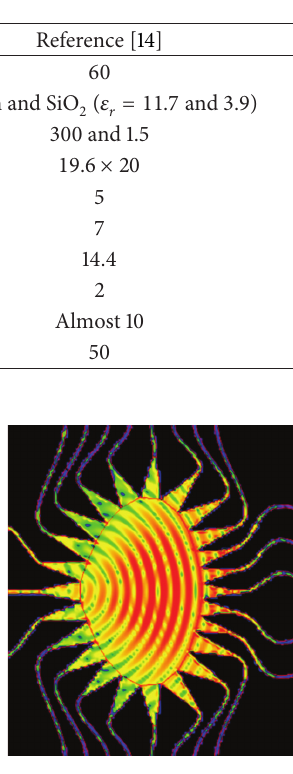
Table 2: Comparison of key features.